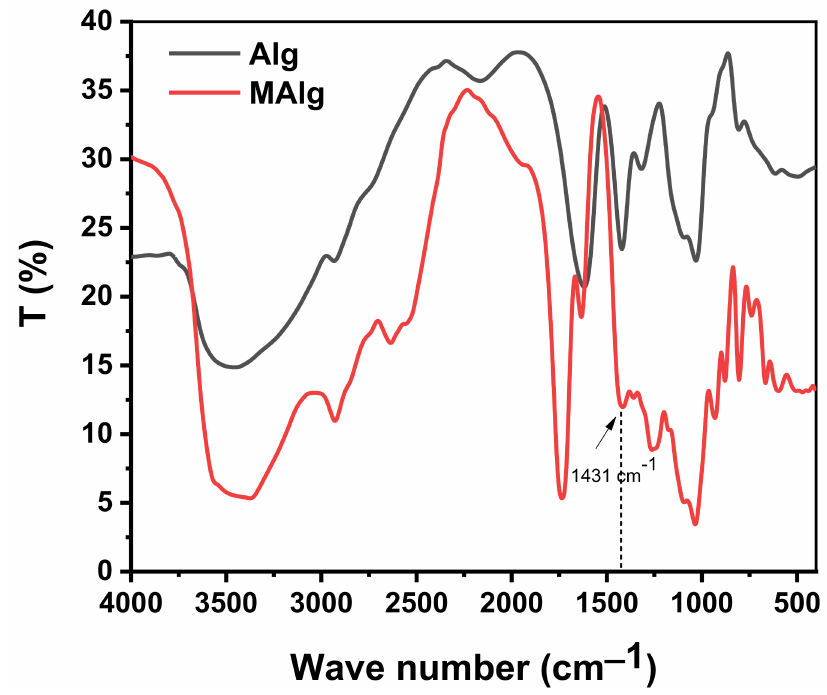
Figure 2. FT-IR of alginic acid and its aromatic derivative. The weak bands at 1358.9, 1173.7, and 1093.7 cm − 1 may be assigned to C–C–H and O–C–H deformation, C–O stretching, and C–O and C–C stretching vibrations of pyranose rings, respectively; the band at 1034.84 cm − 1 can also be because of C–O stretching vibrations. The most frequently discussed region in carbohydrates is the fingerprint or anomeric region (931.6–738.7 cm − 1 ) [46,48]. The spectrum demonstrates a band at 931.6 cm − 1 , which was appointed to the C-O stretching vibration of uronic acid residues, and one at 878.6 cm − 1 , assigned to the C-H deformation vibration of mannuronic acid residues. The band at 804.3 cm − 1 appears to be typical of mannuronic acid residues [49,50].